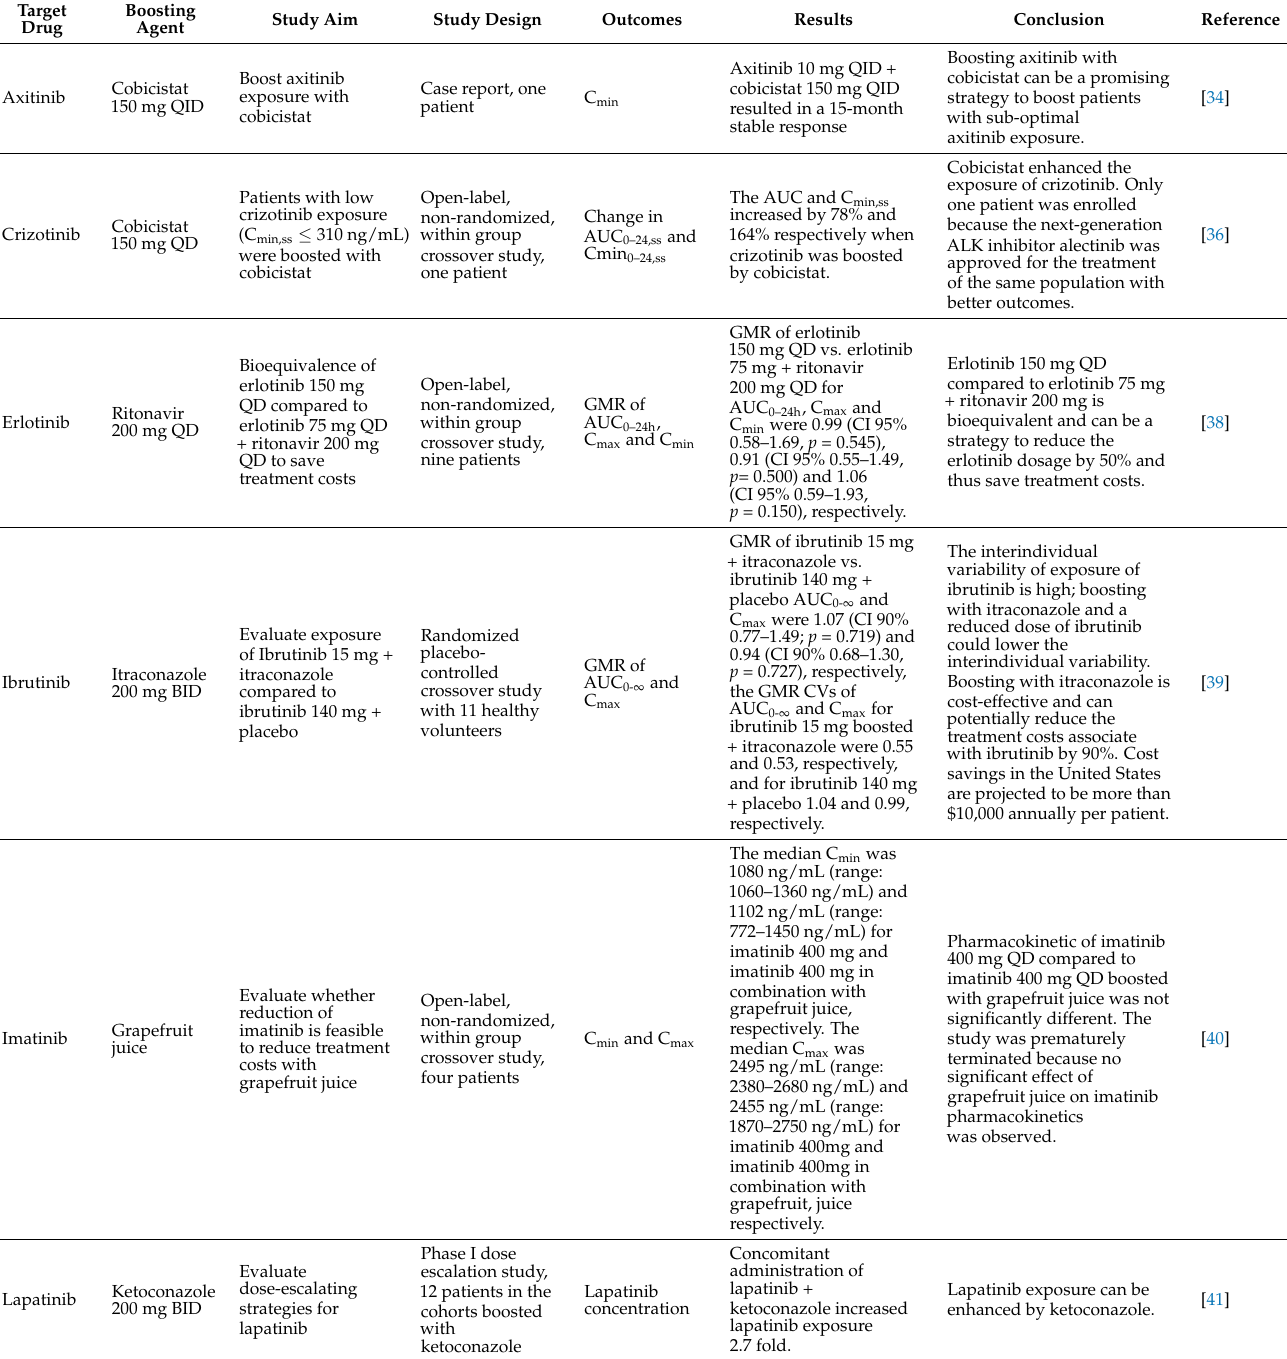
Table 5. Overview of kinase inhibitor boosting